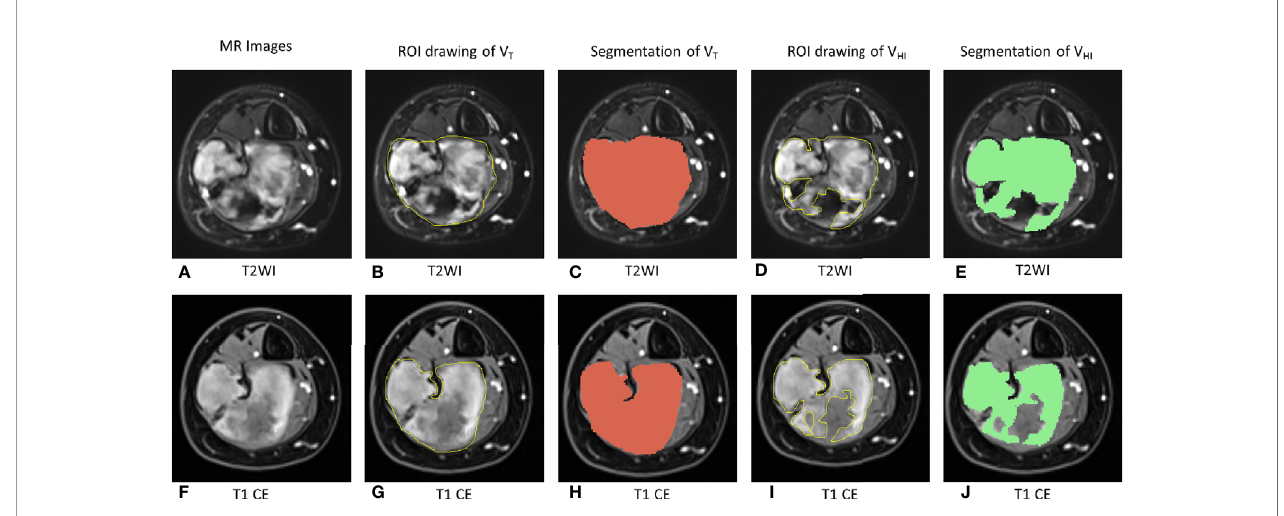
FIGURE 2 | Schematic of evaluation of MRI hyperintensity of pre-therapy MRI. On T2WI, V T = 162,695 mm 3 , V HI = 100,871 mm 3 , HI = 62.0% (grade = 2). On T1 CE, V T = 161,577 mm 3 , V HI = 103,267 mm 3 , HI = 63.9% (grade = 2). V T , The tumor volume; V HI , volume of signal hyperintensity; HI, the hyperintensity percentage of the tumor. (A – E) , T2WI images. (F – J) : T1 CE images. (A, F) : MR images without any drawing. (B, G) : ROI drawing of the tumor volume (V T ). (C, H) : Segmentation of V T . (D, I) : ROI drawing of the volume of signal hyperintensity (V HI ). (E, J) : segmentation of V HI .